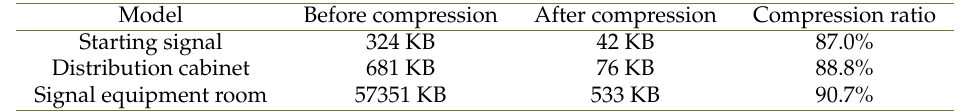
Table 5. Comparison of compressed results